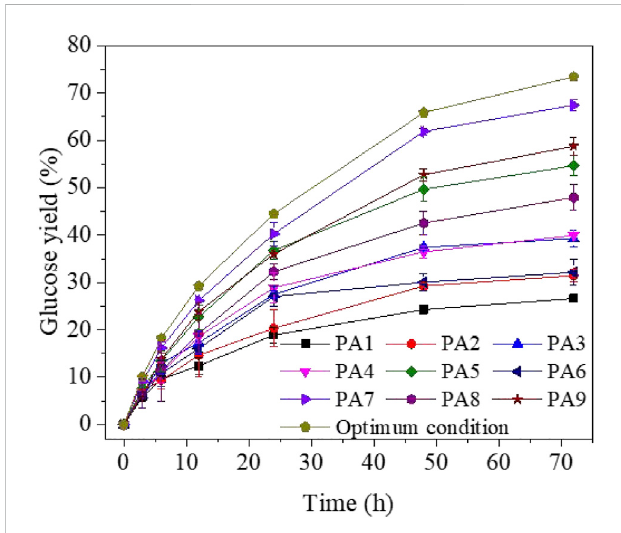
FIGURE 5 Time course of enzymatic hydrolysis of phosphoric acid pretreated substrates 1% cellulose